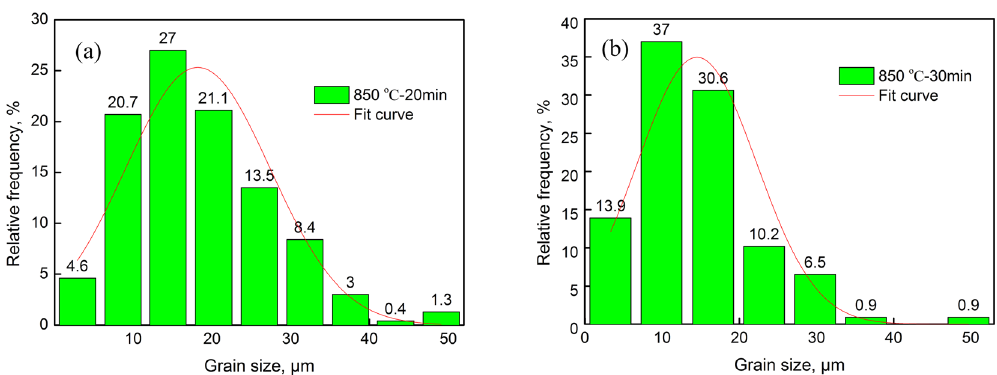
Figure 12. The effects of the heating conditions on the macro-axis size and minor-axis size of the grains. ( a ) Macro-axis size; ( b ) Minor-axis